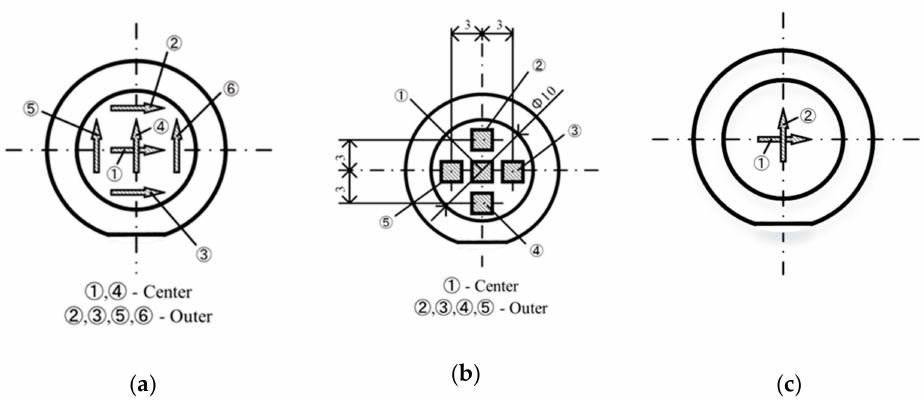
Figure 4. Measuring details: ( a ) surface roughness measuring directions; ( b ) residual stress measuring areas; and, ( c ) surface deformation measuring directions (From edge to edge through the